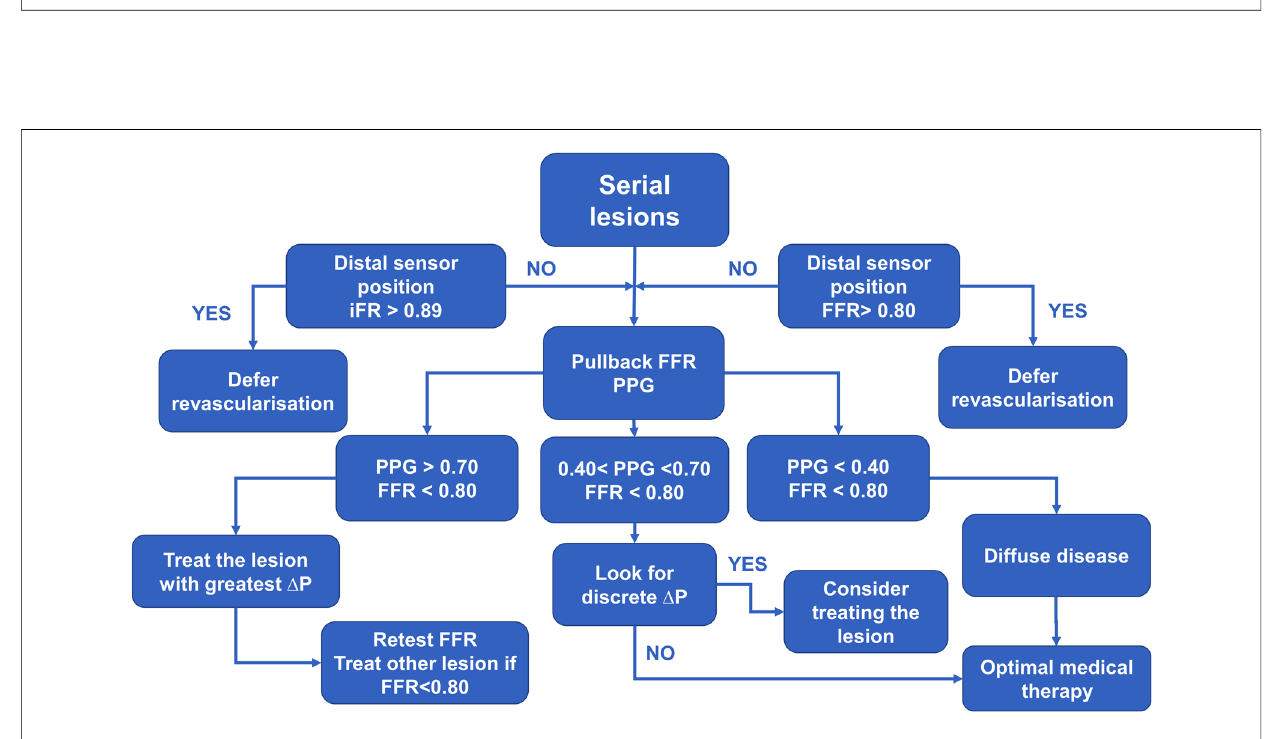
FIGURE 6 The diagram demonstrates practical approach to a patient with serial stenoses using invasive physiology (iFR – instantaneous wave free ratio, FFR – fractional fl ow reserve and PPG – pullback pressure